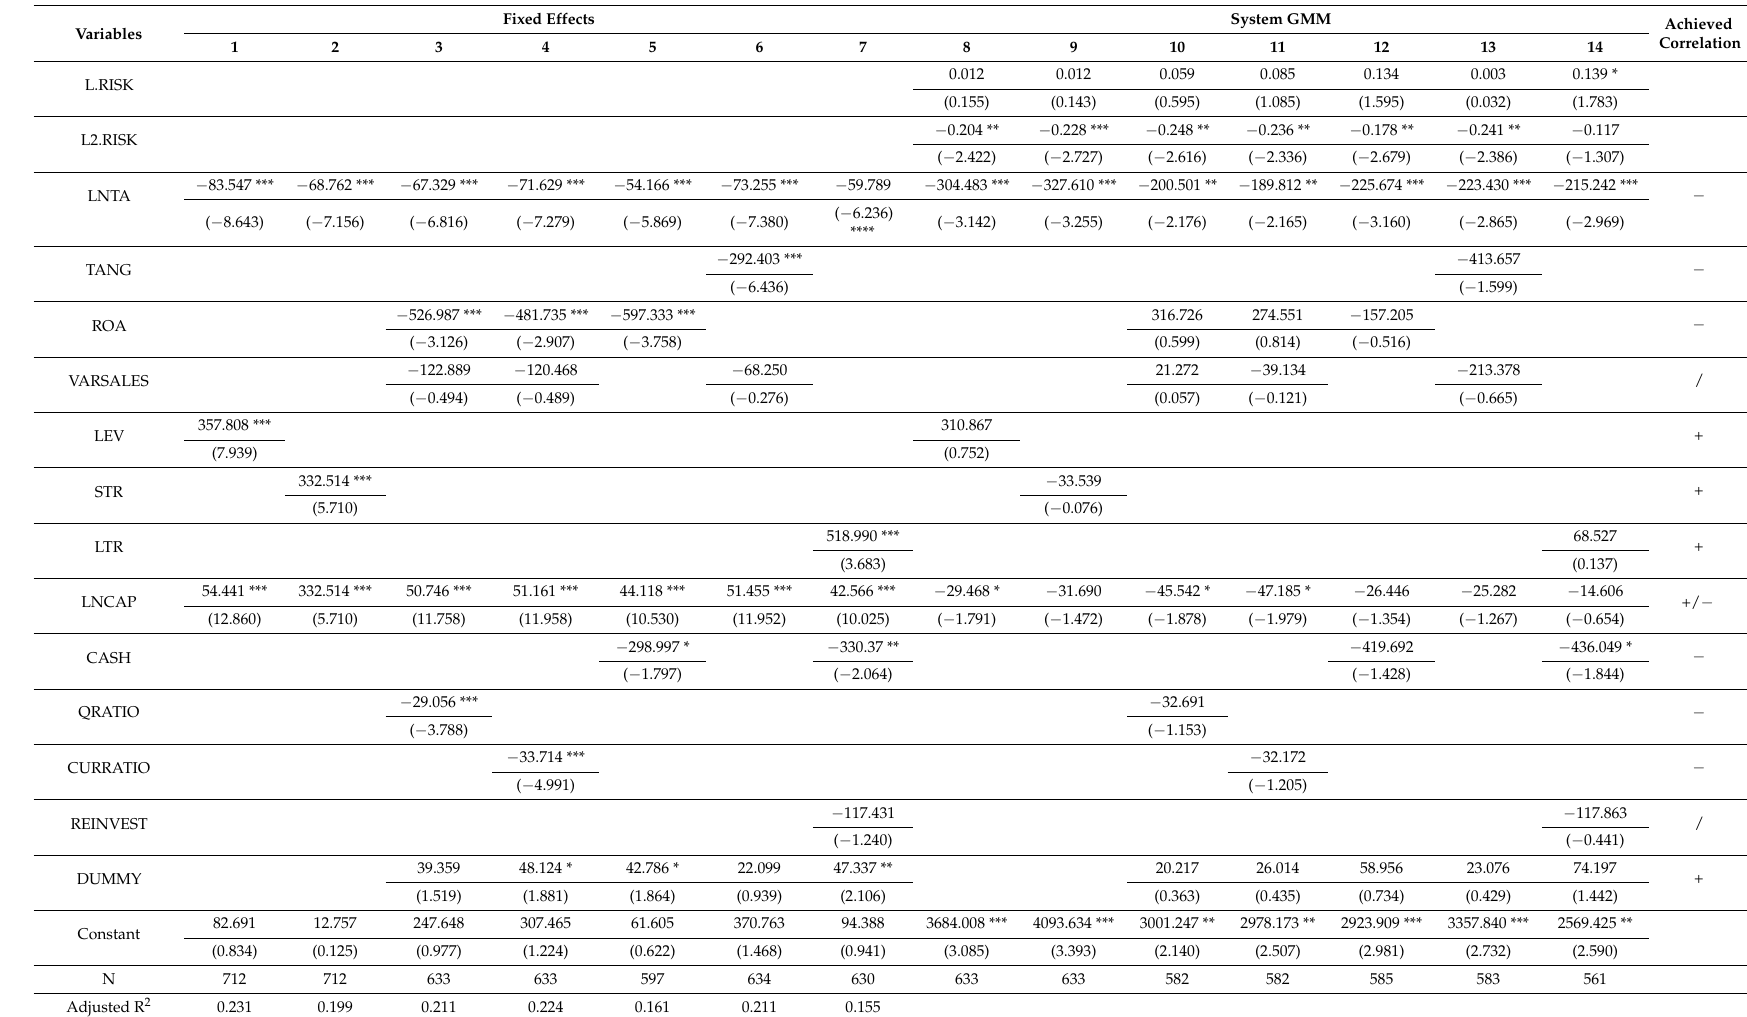
Table 10. Econometric results—dependent variable